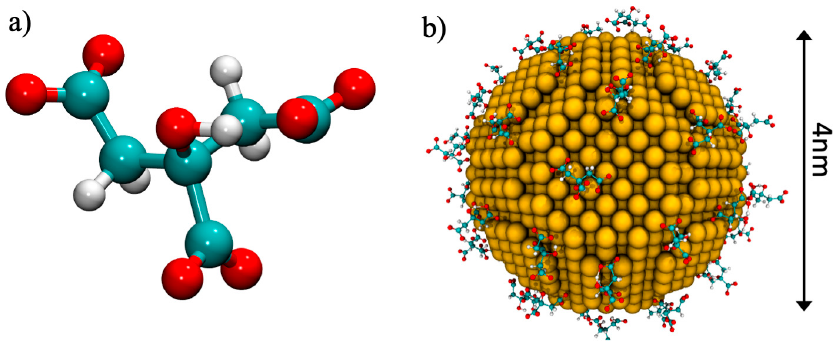
Figure 7. ( a ) The citrate molecule represented in ball-and-stick, and ( b ) the 4-nm diameter AuNP covered by citrates.